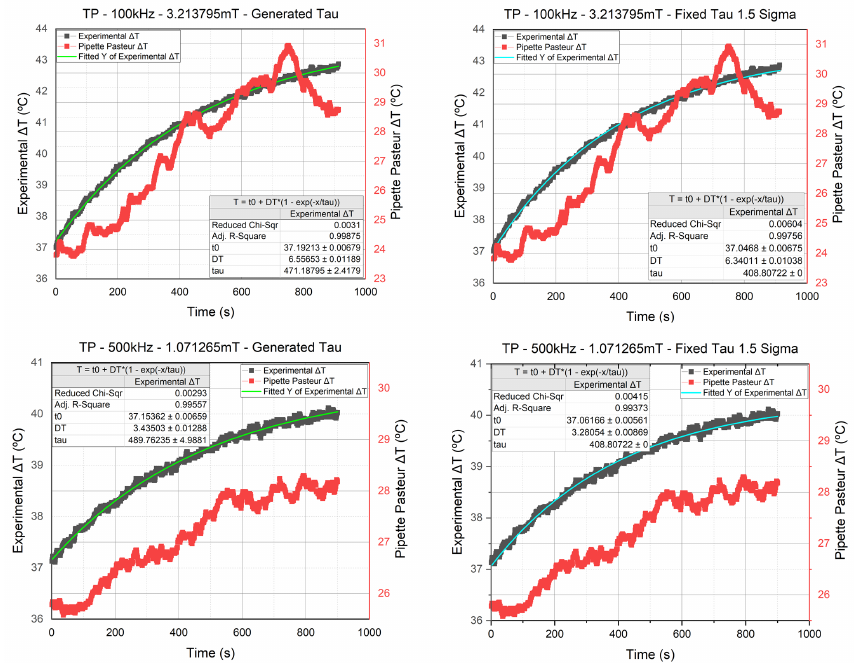
Figure 7. Comparing the curve fittings of the τ T value generated by OriginPro (in green) to the one deduced from the cast - out approach (in cyan) using the experimental results of the TP signal at 100 and 500